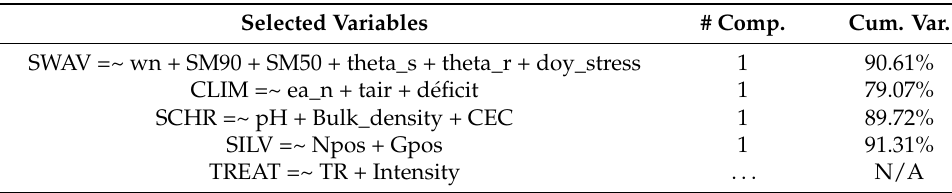
Table 3. Selection of exogenous variables for the SEM analysis, carried out through Principal Com- ponent Analysis (PCA). # comp.: Number of components retained for the PCA optimum solution without rotation (eigenvalue above 1). Cum. Var.: Percentage of the variance of the dataset explained by the retained components (eigenvalue above 1). SWAV = Soil water availability; CLIM = Climatic characteristics; SCHR = Soil characteristics, SILV = Silvicultural characteristics after treatment. See Table 2 for variables description. Selected Variables # Comp. Cum.